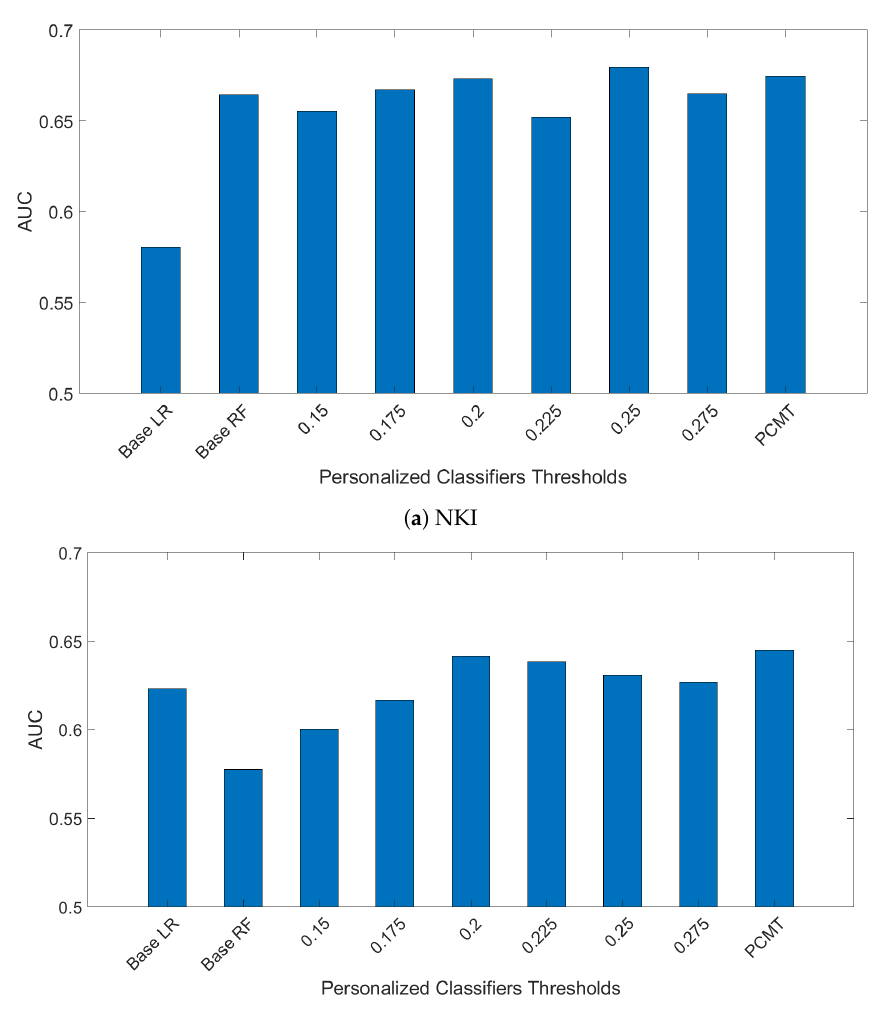
Figure 3. Models are train on ACES dataste only. Then mdoels were evaluted on two independent dataset TCGA and NKI breast cancer